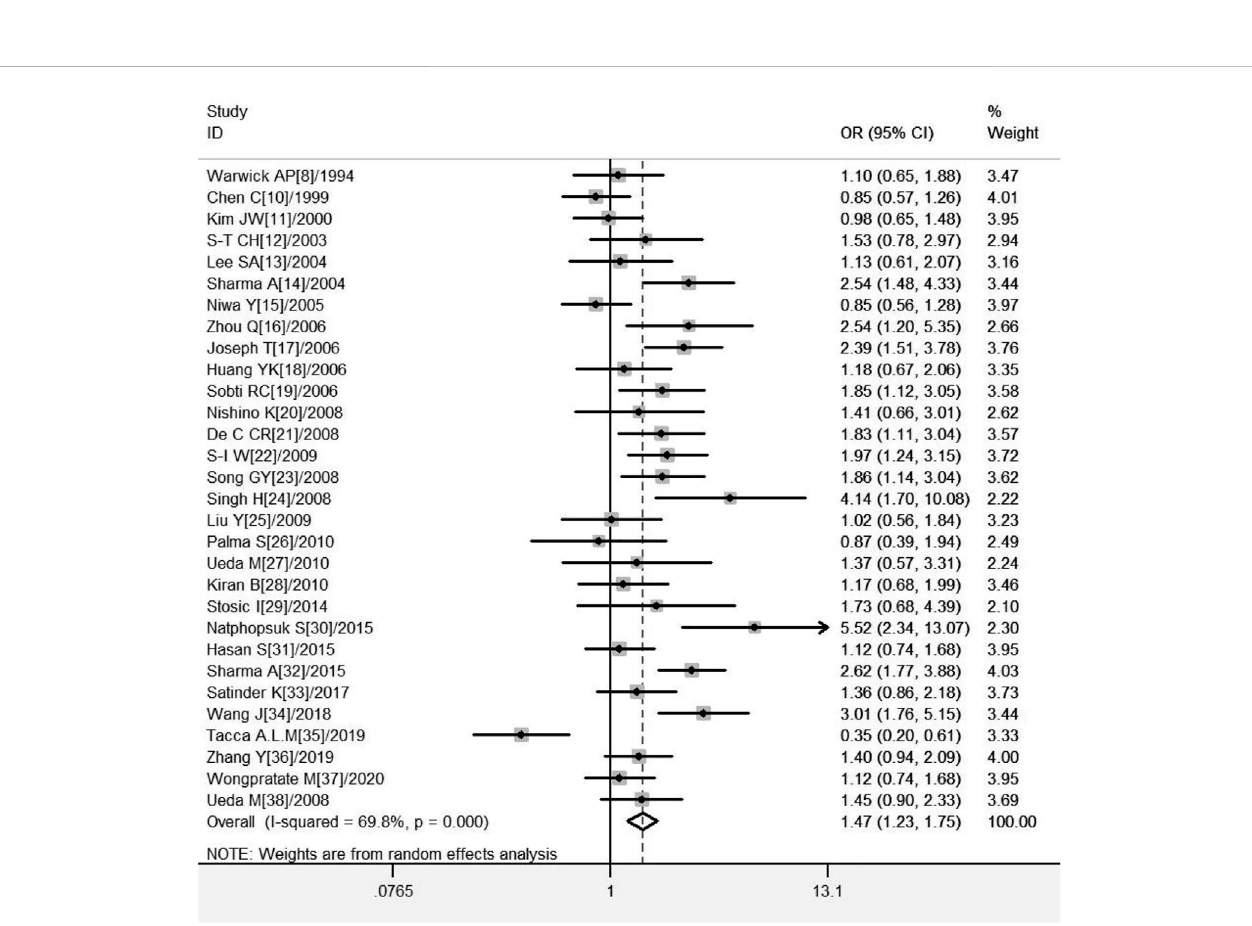
FIGURE 2 Forest plot of meta-analysis of the relationship between GSTM1 gene polymorphisms and cervical cancer